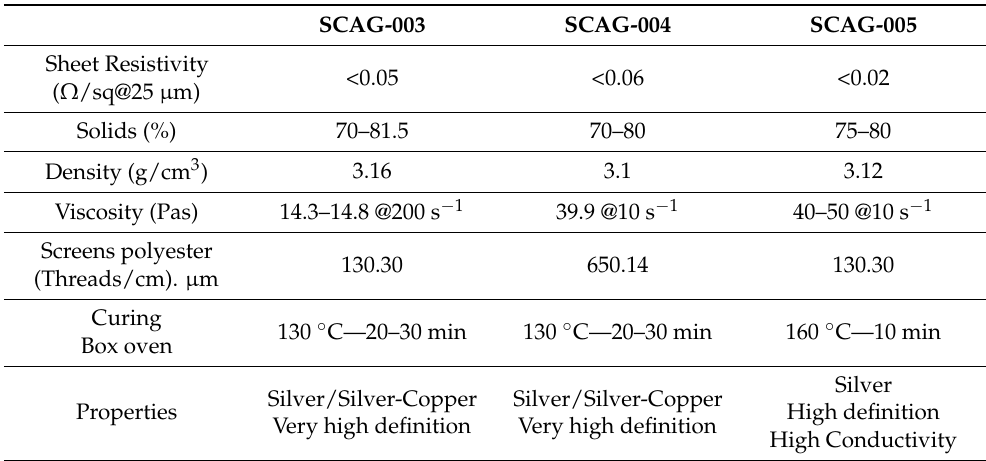
Table 3. Silver inks